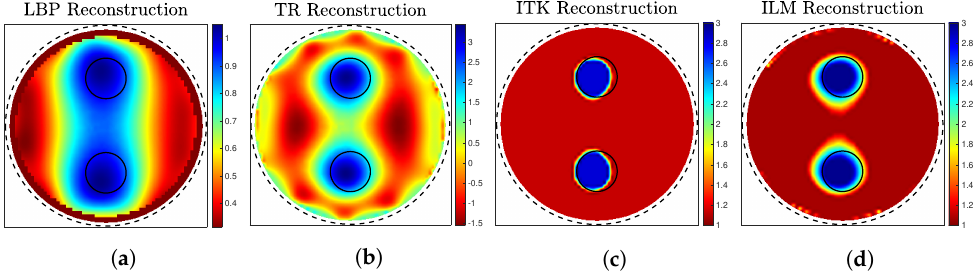
Figure 3. The reconstructed images of air bubbles dispersed in oil. The exact sizes and locations of air bubbles are shown using black circles in the reconstructed images. Images were obtained using ( a ) LBP, ( b ) unprojected TR, ( c ) ITR, and ( d ) ILM reconstruction algorithms,